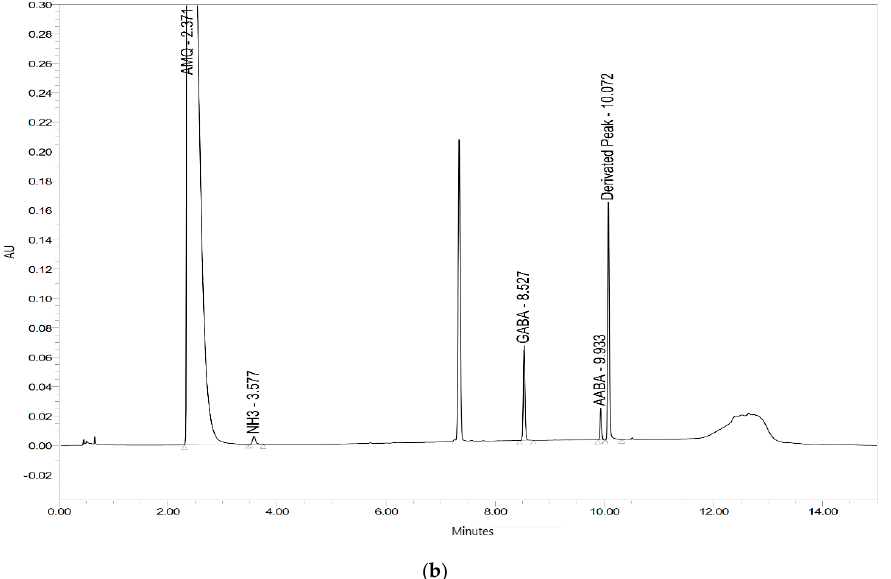
Figure 9. UPLC analysis of GABA in the culture medium of microbial fermentation ( a ) and in the reaction mixture of enzymatic conversion of MSG ( b ). The strain was cultivated in MRS broth containing 118 mM MSG and incubated at 37 ◦ C for 48 h. The culture broth was centrifuged and the supernatans were collected ( a ). Enzymatic conversion was performed with 0.64 U/mL purified GAD using 100 mM MSG in 50 mM citrate-phosphate buffer (pH 4.5) containing 0.2 mM of PLP. The reactions were carried out at 30 ◦ C with 300 rpm agitation ( b ). All samples (microbial fermentations and enzymatic conversion) were hydrolyzed and derivatized prior to UPLC